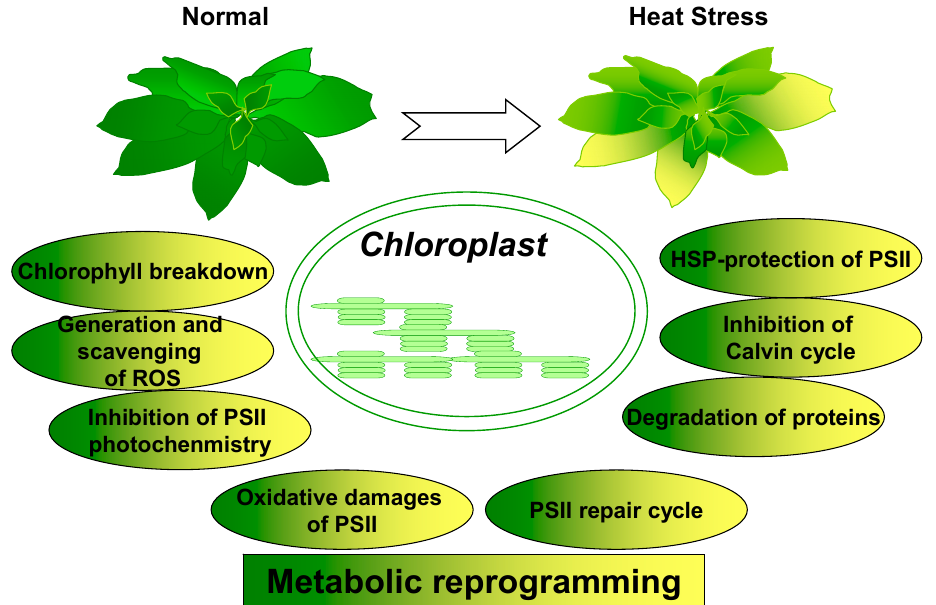
Figure 1. Extensive and transient metabolic reprogramming in chloroplasts under heat stress. Major events of metabolic reprogramming in response to heat stress include chlorophyll breakdown, generation of reactive oxygen species (ROS), antioxidant defense, protein turnover, and metabolic alterations with carbon assimilation. With respect to the systemic acquired acclimation to heat stress in plants, diverse metabolic reprogramming in chloroplasts is required for optimizing plant growth and development during high temperature stresses.